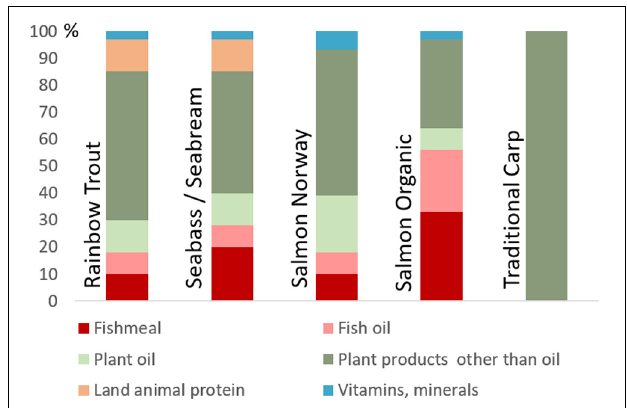
FIGURE 4 | Grower fish feed composition assumptions for selected species and the reference year 2016 based on literature and stakeholder feedback. Fishmeal and oil within organic salmon feed is deriving from fish